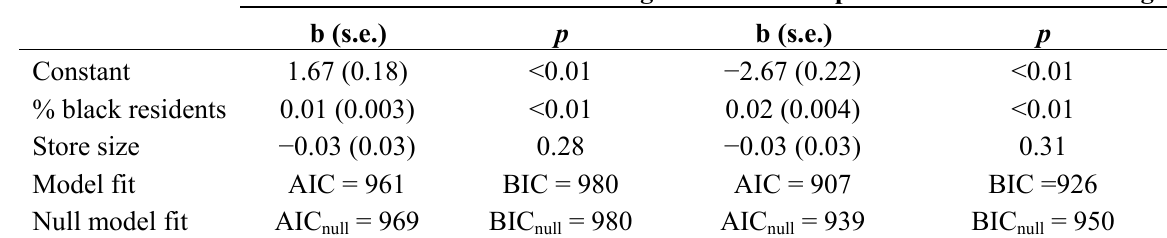
Table 3. The association between tobacco marketing and menthol marketing at the point of sale and the concentration of black residents in census